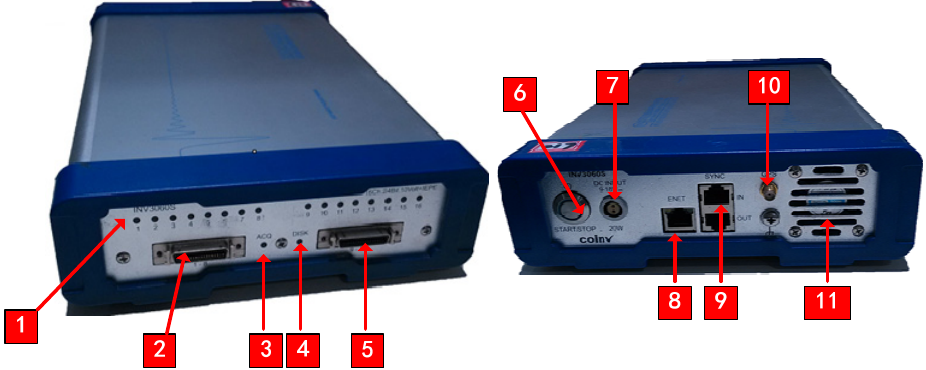
Figure 10. INV3062V 24-bit network-distributed acquisition instrument. Table 11. Acceleration sensor parameters.